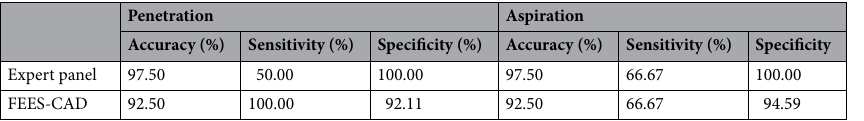
Table 4. Comparison between FEES-CAD and expert panel on penetration and aspiration classification.